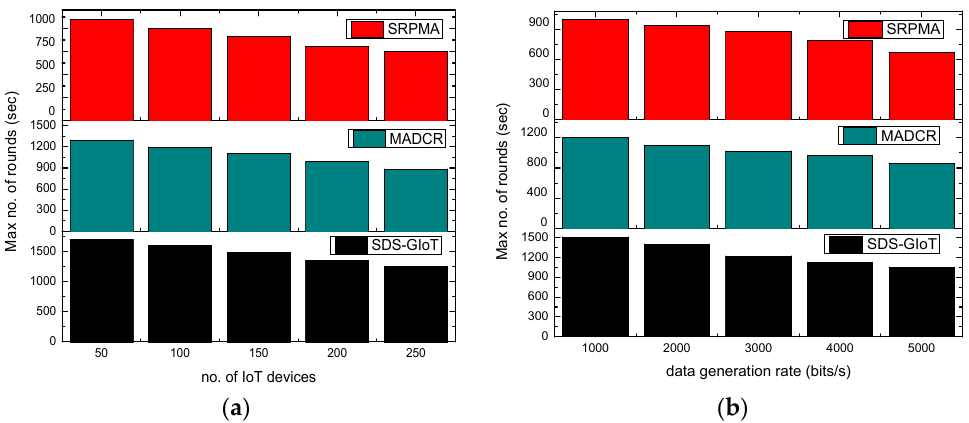
Figure 7. Scenarios for varying IoT devices and data generation rates in terms of no. of rounds. ( a ) Max no. of rounds and IoT devices. ( b ) Max no. of rounds and data generation rates.